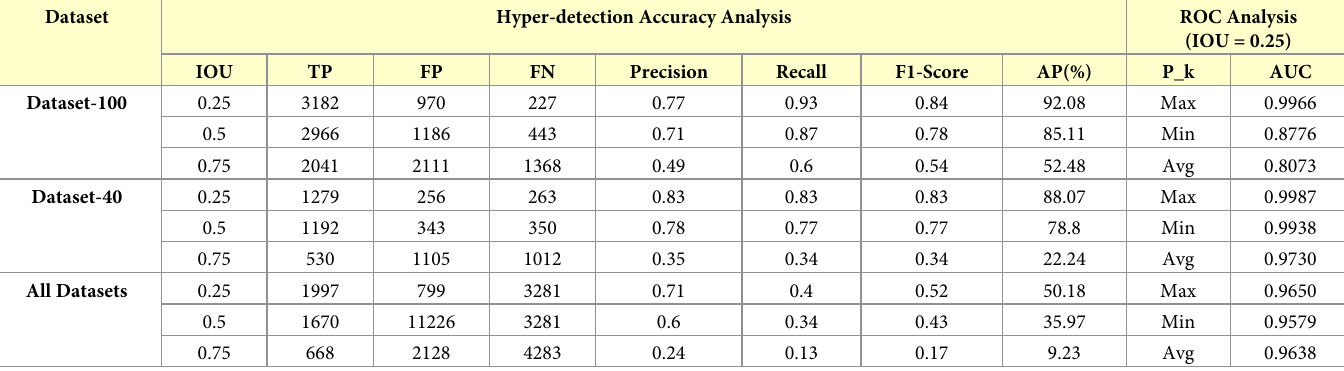
Table 2. Summary of the IOU, TP, FP, FN, precision, recall, F1-score, AP, and AUC values of our model. Dataset